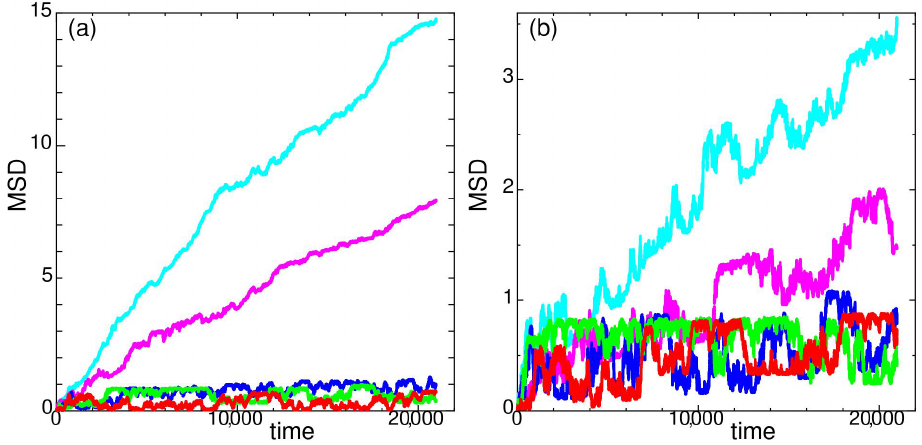
Figure 7. Mean square displacement of state O at temperatures ( a ) T = 80 (red), 100 (green), 116 (blue), 128 (magenta), 132 (cyan), ( b ) T = 88 (red), 96 (green), 108 (blue), 120 (magenta), 124 (cyan), for system size N = 5376.